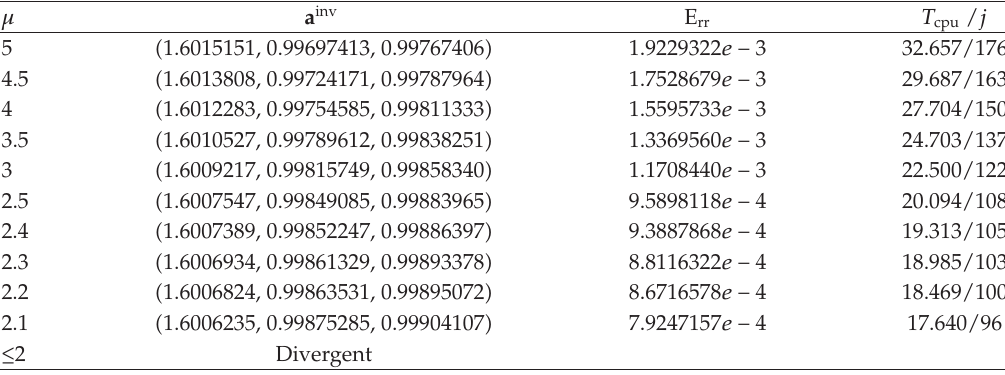
Table 4: Influence of regularization parameter on the algorithm with τ (cid:8) 0 .